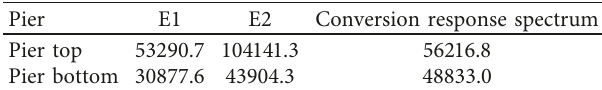
Table 4: Bending moment of pier (unit: kN m).